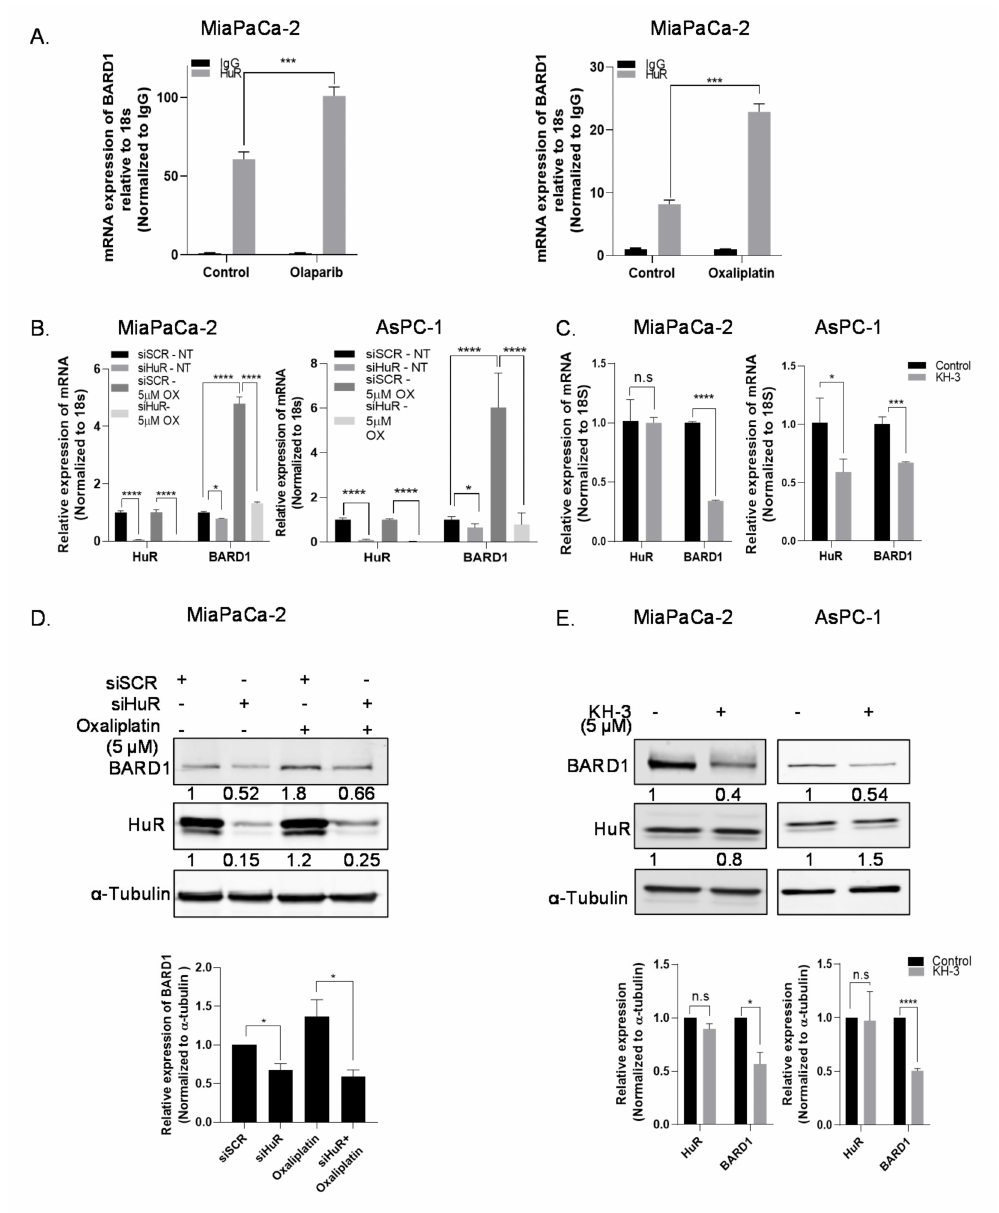
Figure 2. HuR regulates mRNA and protein expression of BARD1. ( A ) Independent HuR-RNP-IP was performed after treating cells with either olaparib (10 µ M) or oxaliplatin (5 µ M) and BARD1 mRNA expression was calculated relative to 18 s by RT-qPCR. Mean ± SEM, n = 3. *** p < 0.001 (Student’s t - test). ( B ) Relative mRNA expression of BARD1 in MiaPaCa-2 and AsPC-1 PDAC cells after treatment of cells with oxaliplatin and siHuR (siHuR#1) transfection. * p < 0.05, **** p < 0.0001. ( C ) Relative mRNA expression of BARD1 in MiaPaCa-2 and AsPC-1 cells treated with KH-3 (5 µ M) for 48 h. Mean ± SEM, n = 3. *** p < 0.001, * p < 0.05, n.s, non-significant. (Student’s t -test). ( D , E ) Western blot analysis of the protein expression of BARD1, HuR, and α -tubulin in MiaPaCa-2 cells treated with oxaliplatin (5 µ M) and transfected with siHuR (siHuR#1) for 48 h or treated with KH-3 for 72 h. Representative blots and graphs showing relative band intensities is shown. Mean ± SEM from n = 3, * p < 0.05, **** p < 0.0001, n.s, non-significant. (Student’s t -test). To determine the impact of this direct binding, we silenced HuR in PDAC cells and evaluated changes in total BARD1 mRNA expression. HuR silencing decreased mRNA expression of BARD1 in both MiaPaCa-2 and AsPC-1 cell lines; treatment of